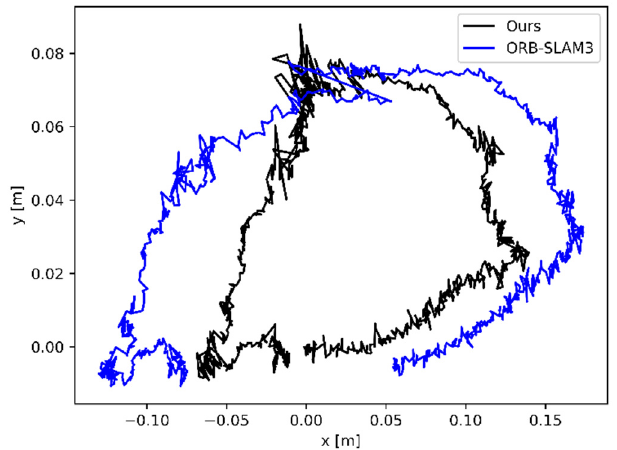
Figure 15. Comparison of ORB-SLAM3 and our system in indoor environment.